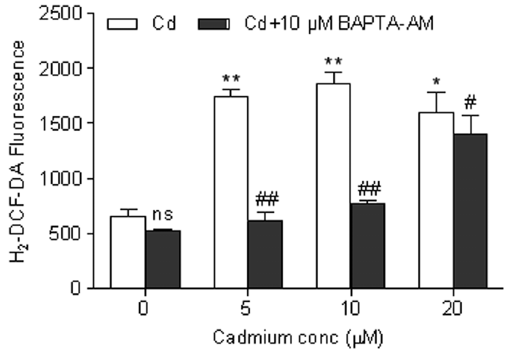
Figure 5. Cd-elevated [Ca 2 + ] i induces ROS in cerebral cortical neurons. Cells were pretreated with BAPTA-AM (10 m M) for 30 min, followed by treatment with Cd for another 12 h. The generation of ROS was analyzed by H 2 -DCF-DA staining using flow cytometry. Results were expressed as mean fluorescence. Each bar represents mean 6 SD (n=6). *Statistical significance between control and Cd treatment (5, 10 and 20 m M); # Statistical significance between cells cultured in the absence and presence of BAPTA-AM. ns Not significant; * P , 0.05,